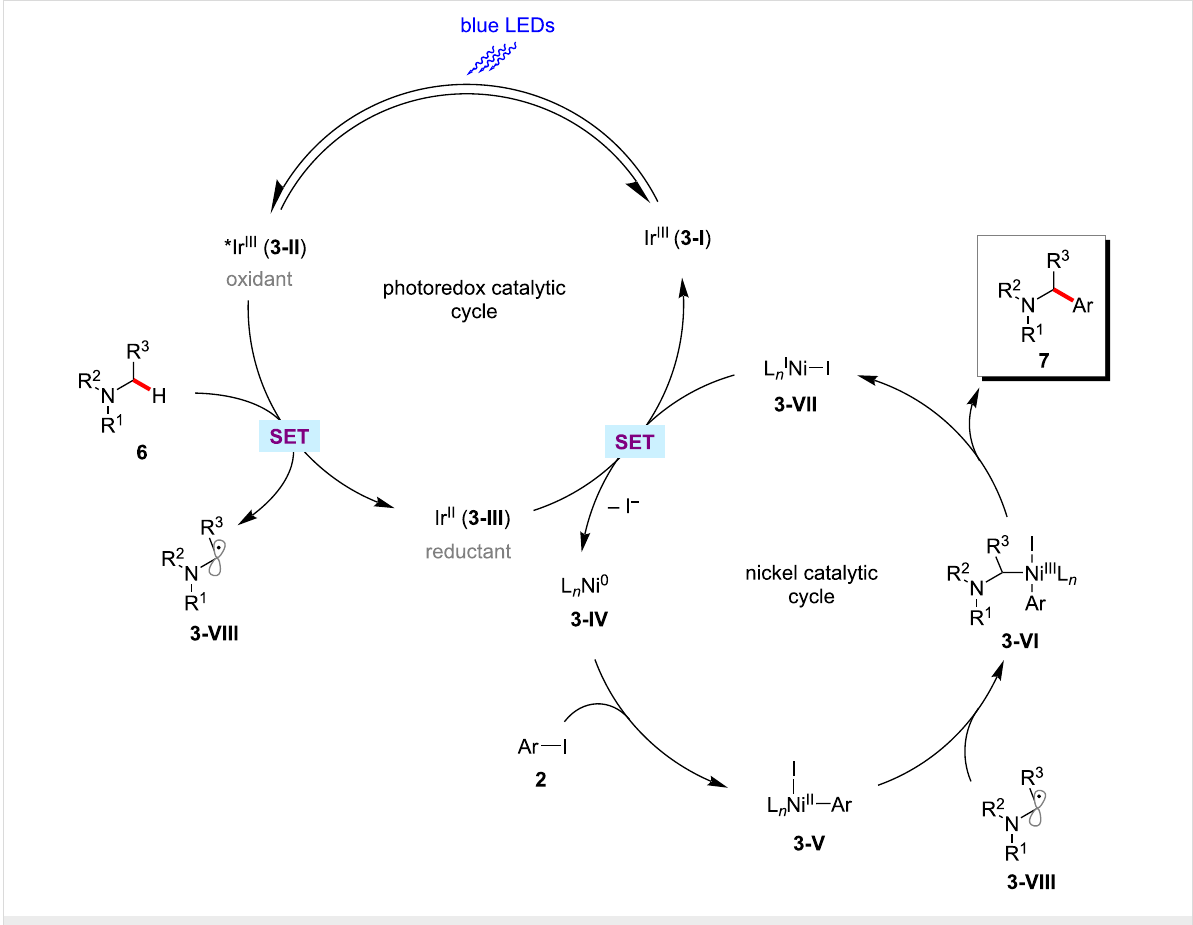
Figure 3: Proposed mechanism for photoredox nickel-catalyzed α -amino C ‒ H arylation with aryl iodides.